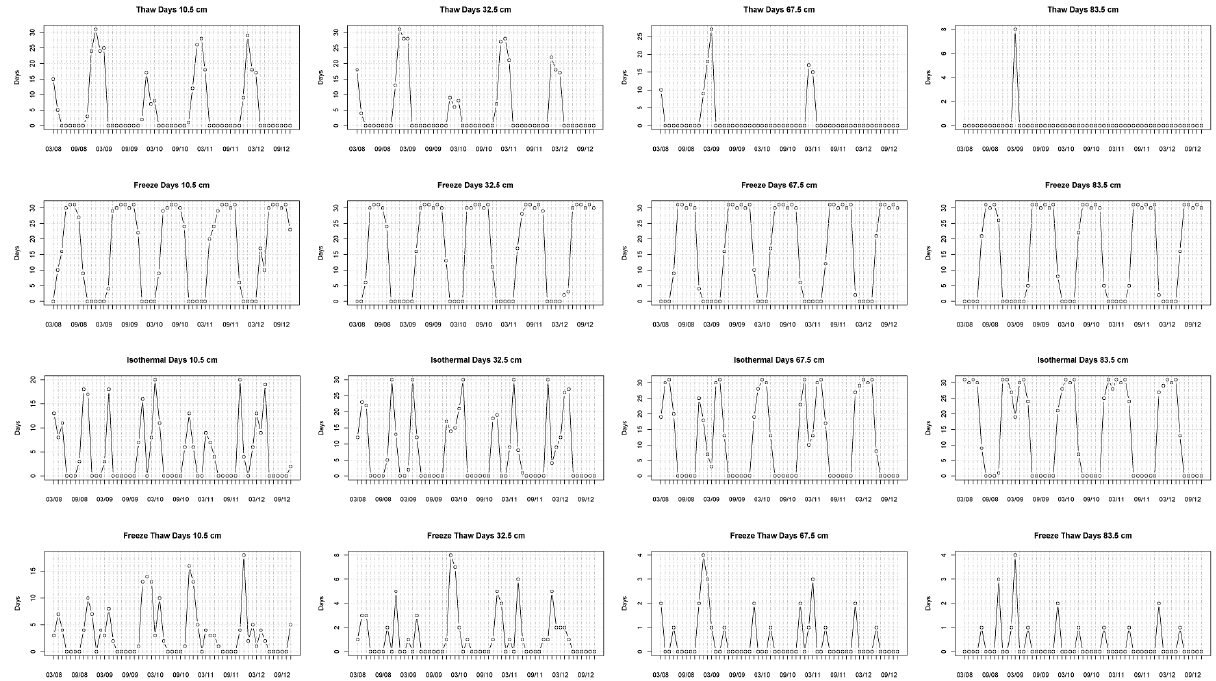
Figure 3. Thaw days, freeze days, isothermal days and freeze–thaw days for F1, F2, F3 and F4.